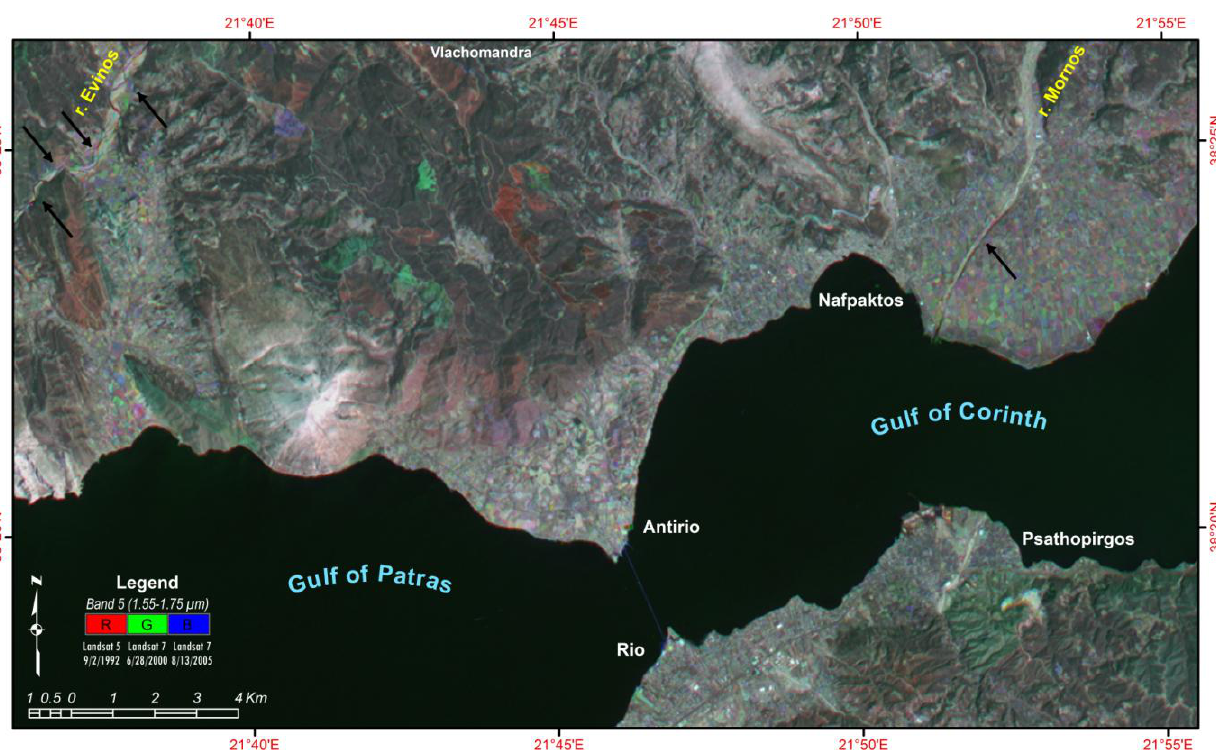
Figure 6. Multi-temporal pseudo-color image produced from layer stacking of Landsat satellite data (Band 5, 1.55 to 1.75 μm) with three different acquisition dates. The pattern of water flow in the rivers has shifted throughout the thirteen year observation period as indicated by crosscutting linear features of different colors. The black arrows point to alterations of the surface described in the